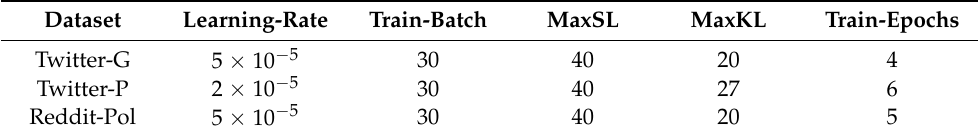
Table 2. Different hyperparameters for different datasets in the experiment.